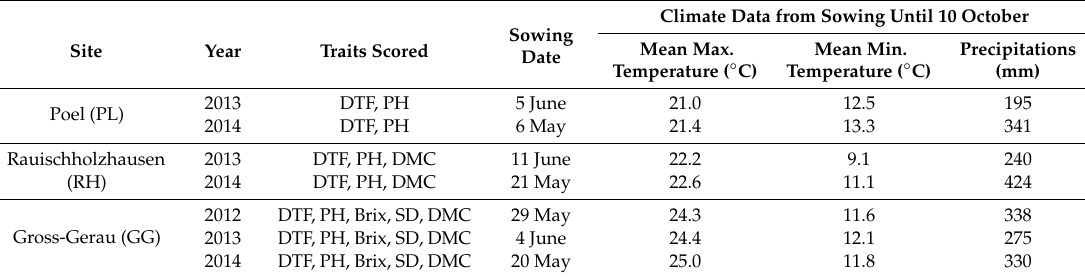
Table 3. Overview of the field experiments scoring maturity and agronomical traits. DTF, days to flowering; PH, plant height; DMC, dry matter content; SD, stem